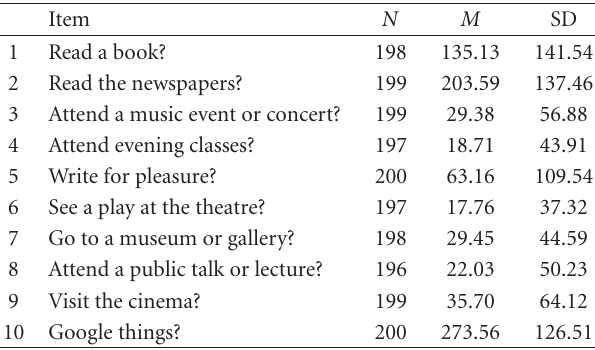
Table 1: Descriptives of cognitive activity engagement